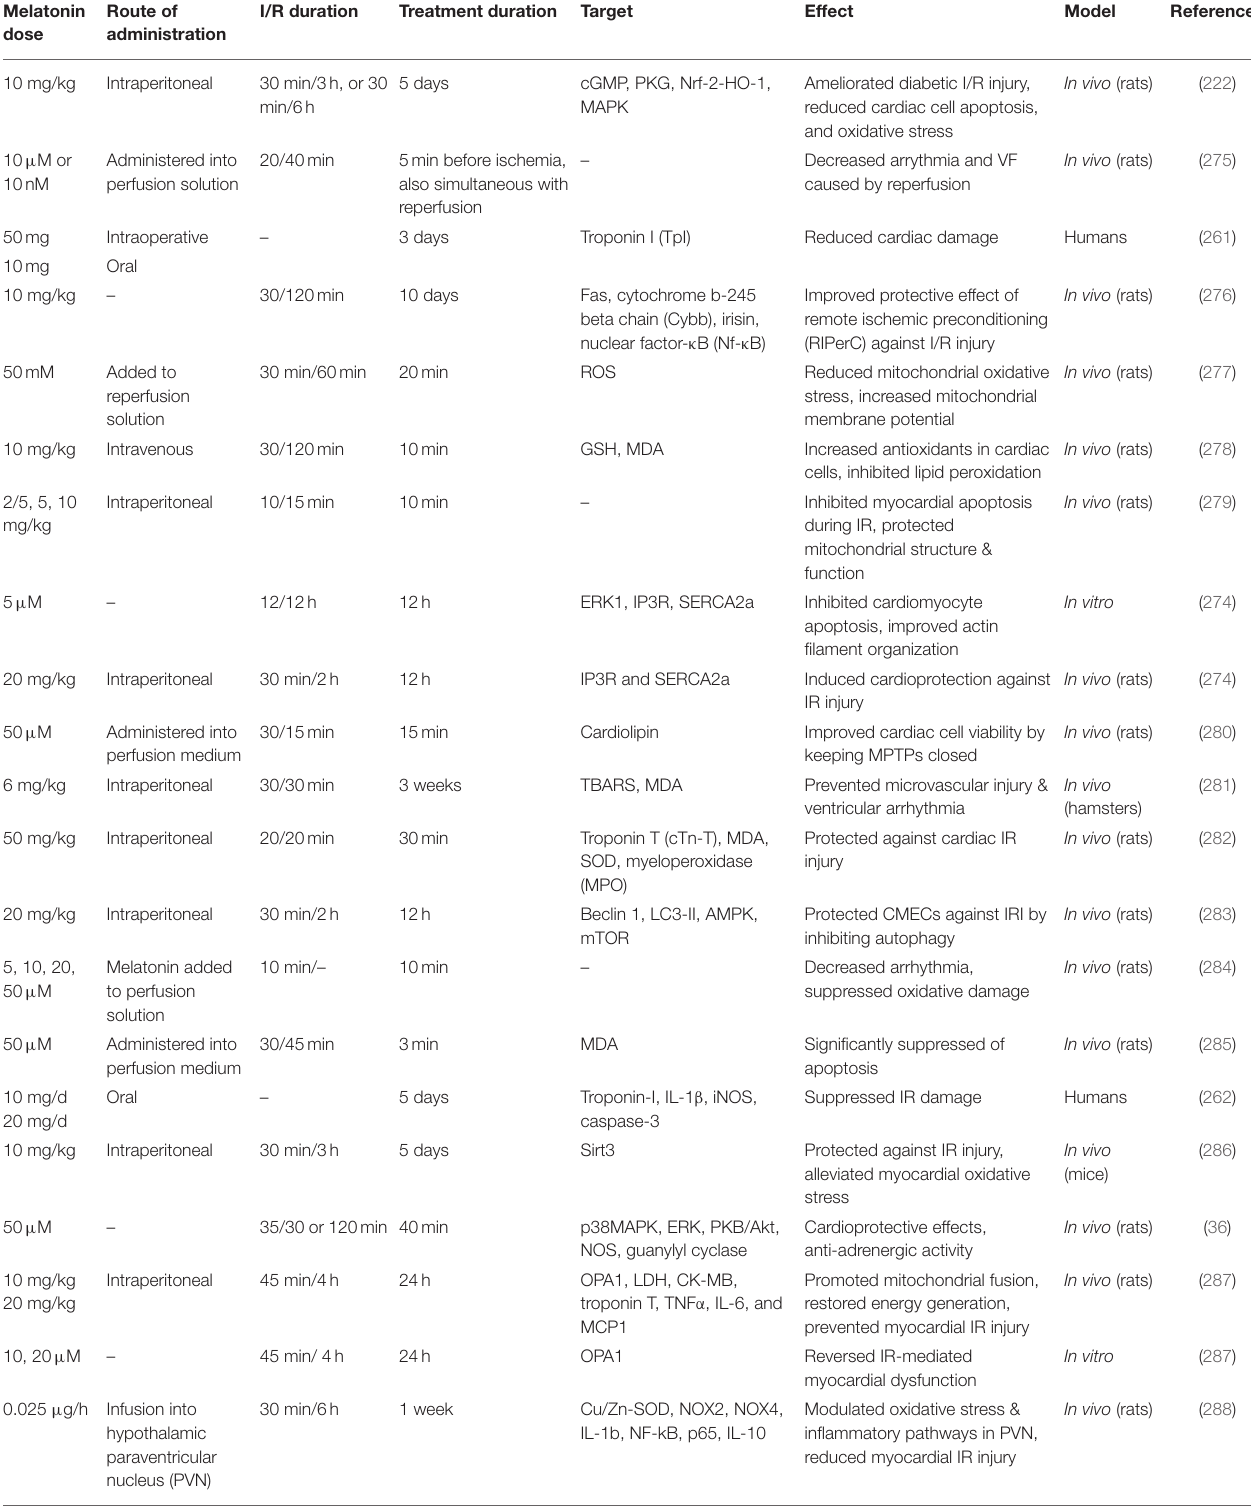
TABLE 3 | Therapeutic effects of melatonin against ischemia-reperfusion injury. Melatonin